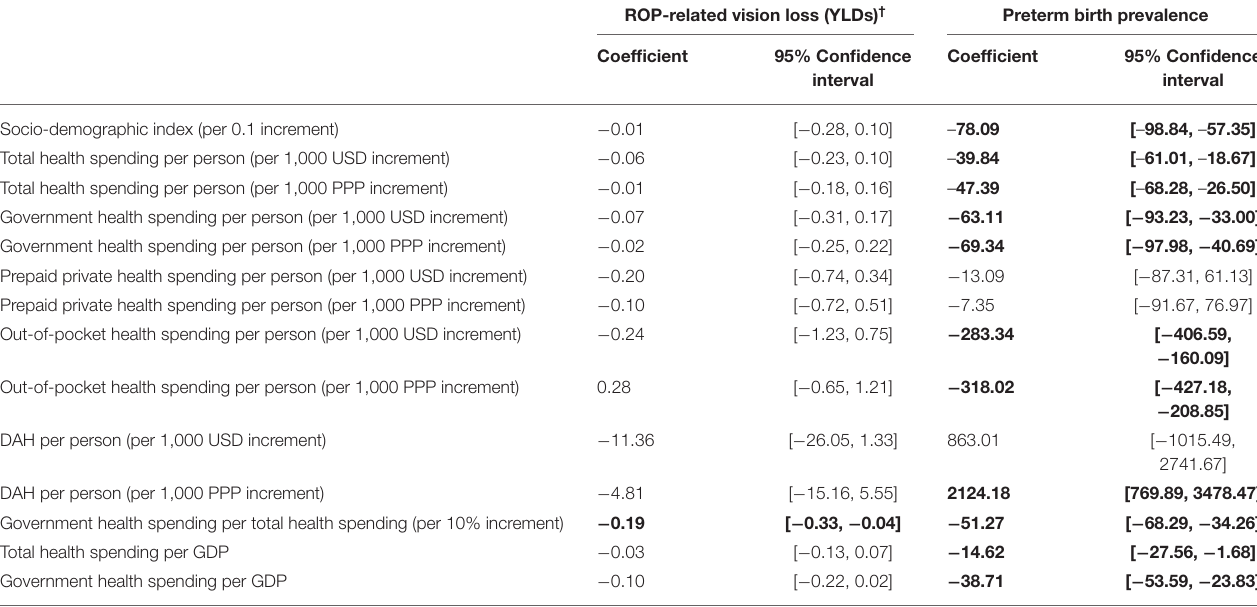
TABLE 1 | Association between Health spending with burden of ROP-related vision loss and preterm prevalence among 204 countries and territories in